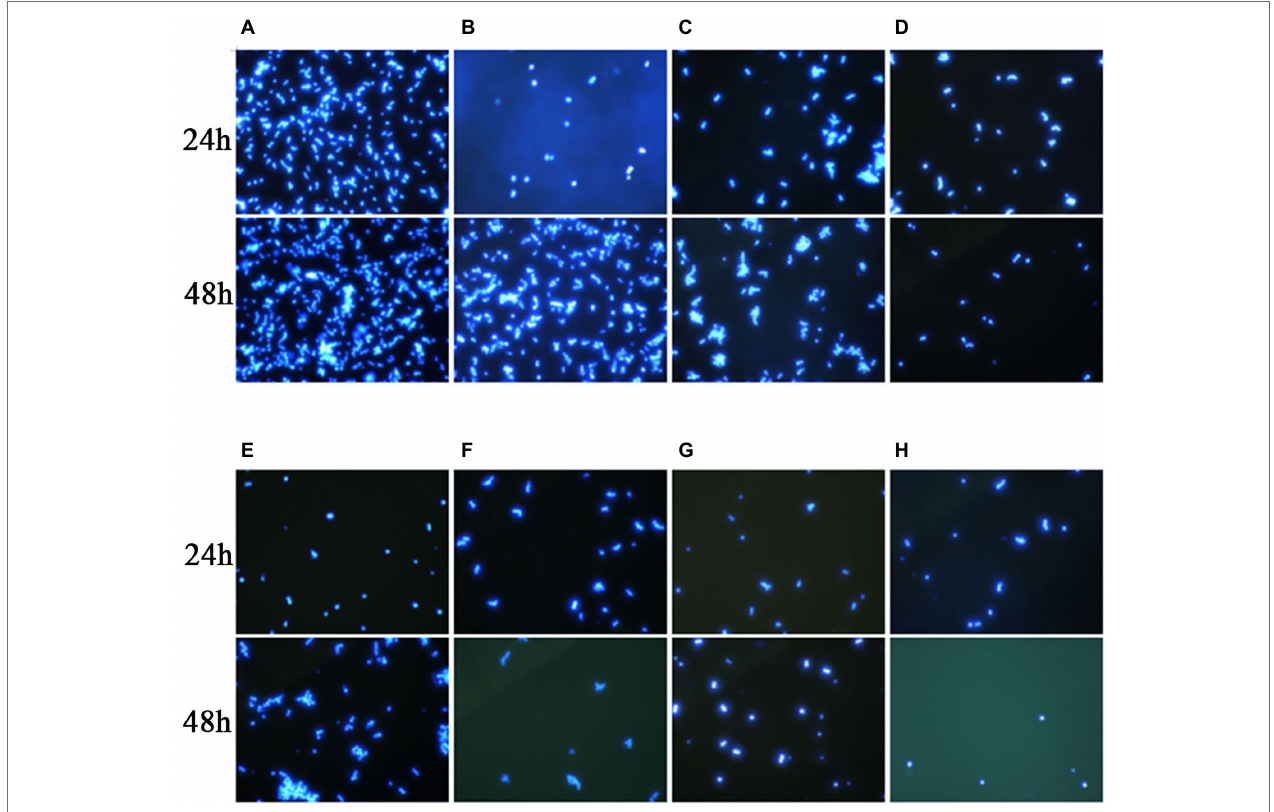
FIGURE 3 | Effects of 17-AAG and azole monotherapy and in combination on biofilm formation by C. auris AR 382. (A) No drug; (B) 17-AAG; (C) ITR; (D) 17-AAG + ITR; (E) VOR; (F) 17-AAG + VOR; (G) POS; and (H) 17-AAG + POS.